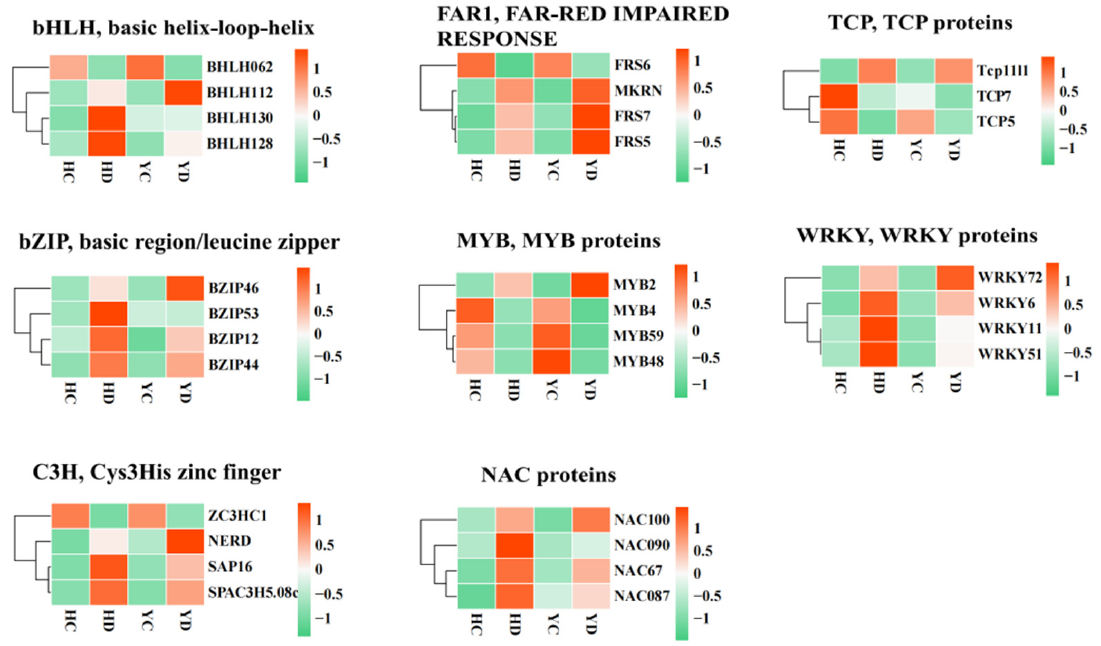
Figure 5. Heat map diagrams of the relative expression levels of TFs annotated in anthocyanin biosynthesis in millet: bHLH, basic helix ‐ loop ‐ helix; bZIP, basic region/leucine zipper; C2H2, C2H2 zinc ‐ finger proteins; C3H, Cys3His zinc finger; FAR1, far ‐ red impaired response 1; TCP, TCP proteins; WD40, WD40 repeat proteins; MYB, MYB proteins; NAC, NAC proteins; and WRKY, WRKY proteins.